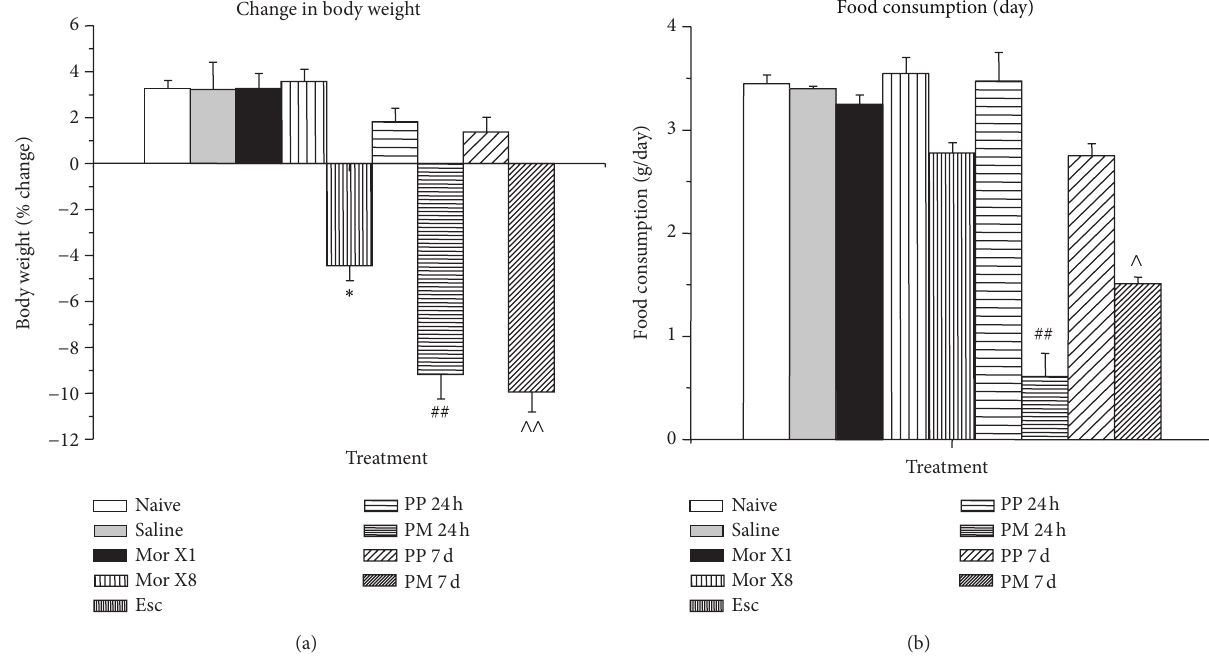
Figure 2: Body weight change (% of initial body weight) (a) and food intake (g/day) (b) following different morphine treatments. See Table 1 for details on the morphine treatment paradigm. 𝑁 = 3 - 4 per treatment. ∗ 𝑃 < 0.05 , versus saline injection, ## 𝑃 < 0.0001 versus 24 h placebo pellet, ∧ 𝑃 < 0.05 versus 7 d placebo pellet, ∧∧ 𝑃 < 0.0001 versus 7 d placebo